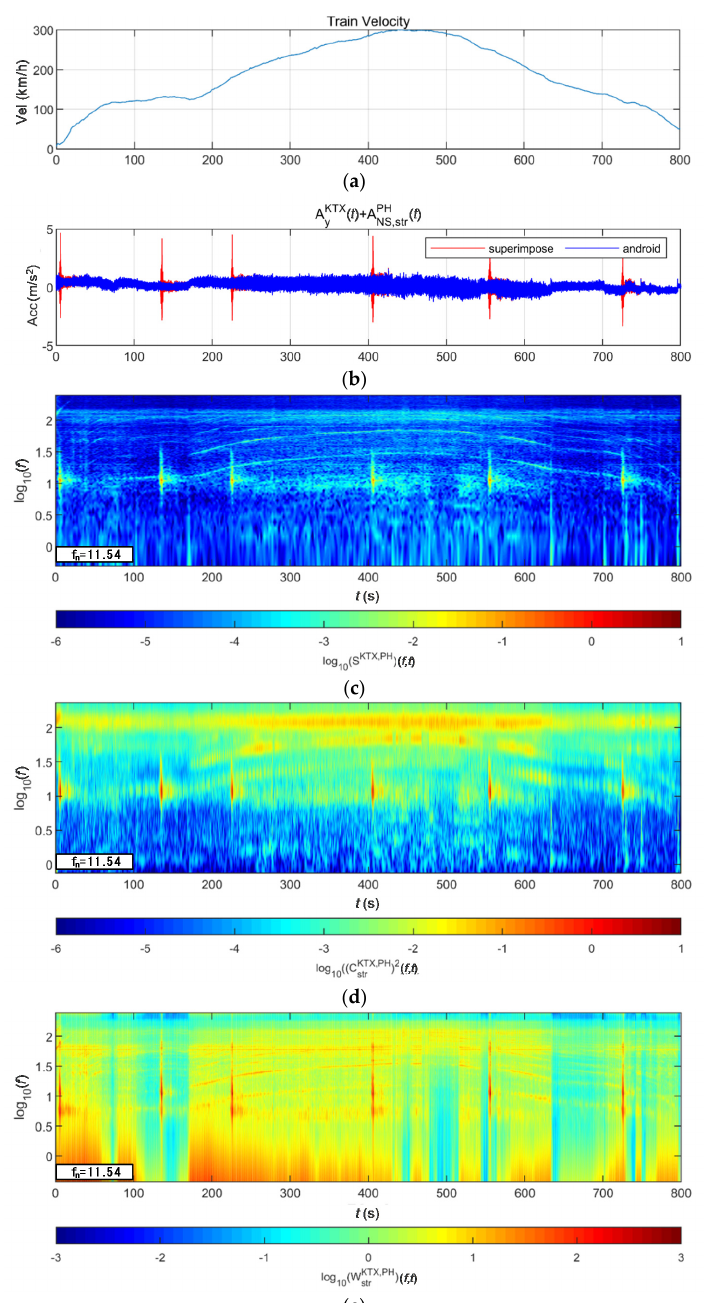
Figure 31. Combination of train data with BR2 bridge-response data from the Pohang earthquake (scaled to 2400-year return period): ( a ) velocity; ( b ) lateral acceleration time series; ( c ) STFT; ( d ) WT; ( e ) WVD.